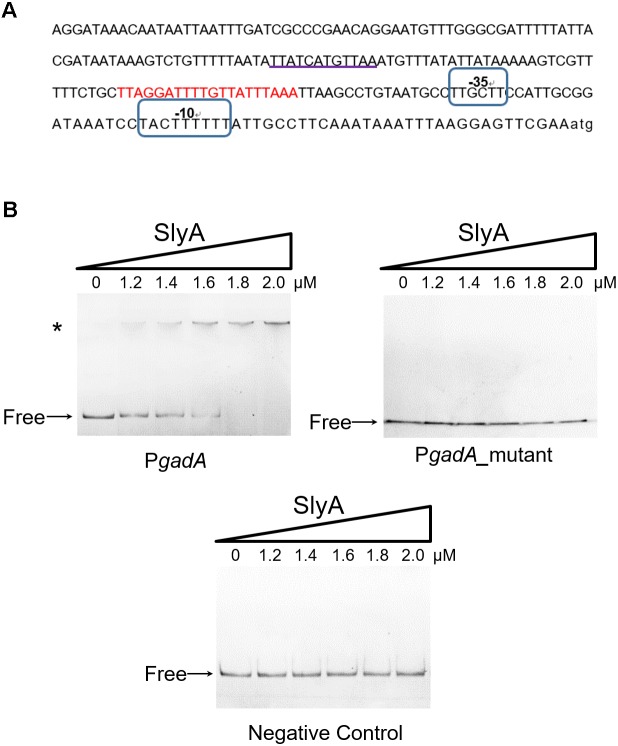
SlyA directly binds to the promoter region of the gadA gene. (A) Bioinformatics analysis of the gadA promoter region (PgadA). The sequence of the gadA promoter region of 224 bp upstream of the start codon is shown and the putative SlyA-binding site is underlined. Putative –10 and –35 elements are circled and the gad box is indicated in red. (B) EMSA experiments determined the direct binding of SlyA to PgadA. Different concentrations of purified SlyA (ranging from 0 to 2 μM) were incubated with PgadA, PgadA lacking the SlyA-binding site (PgadA_mutant) or negative control DNA prior to electrophoretic separation. “Free” indicates free DNA and the asterisk indicates DNA-protein complexes.